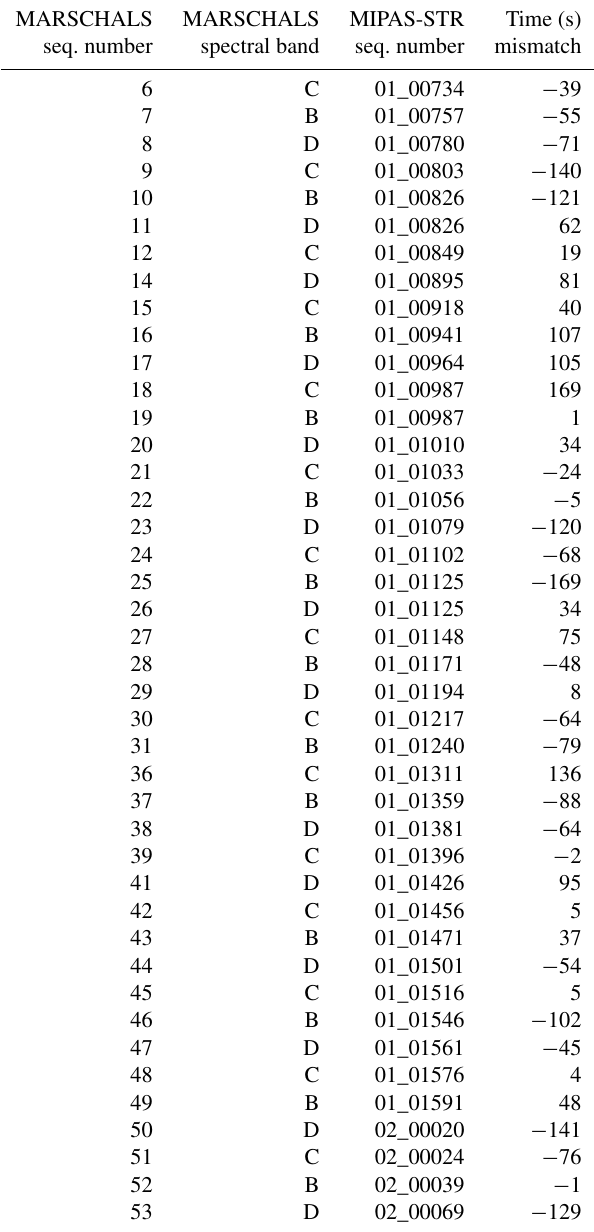
Table 3. Best matching sequences of MARSCHALS and MIPAS- STR measurements selected for the synergistic data analysis. MARSCHALS MARSCHALS MIPAS-STR Time (s) seq. number spectral band seq.